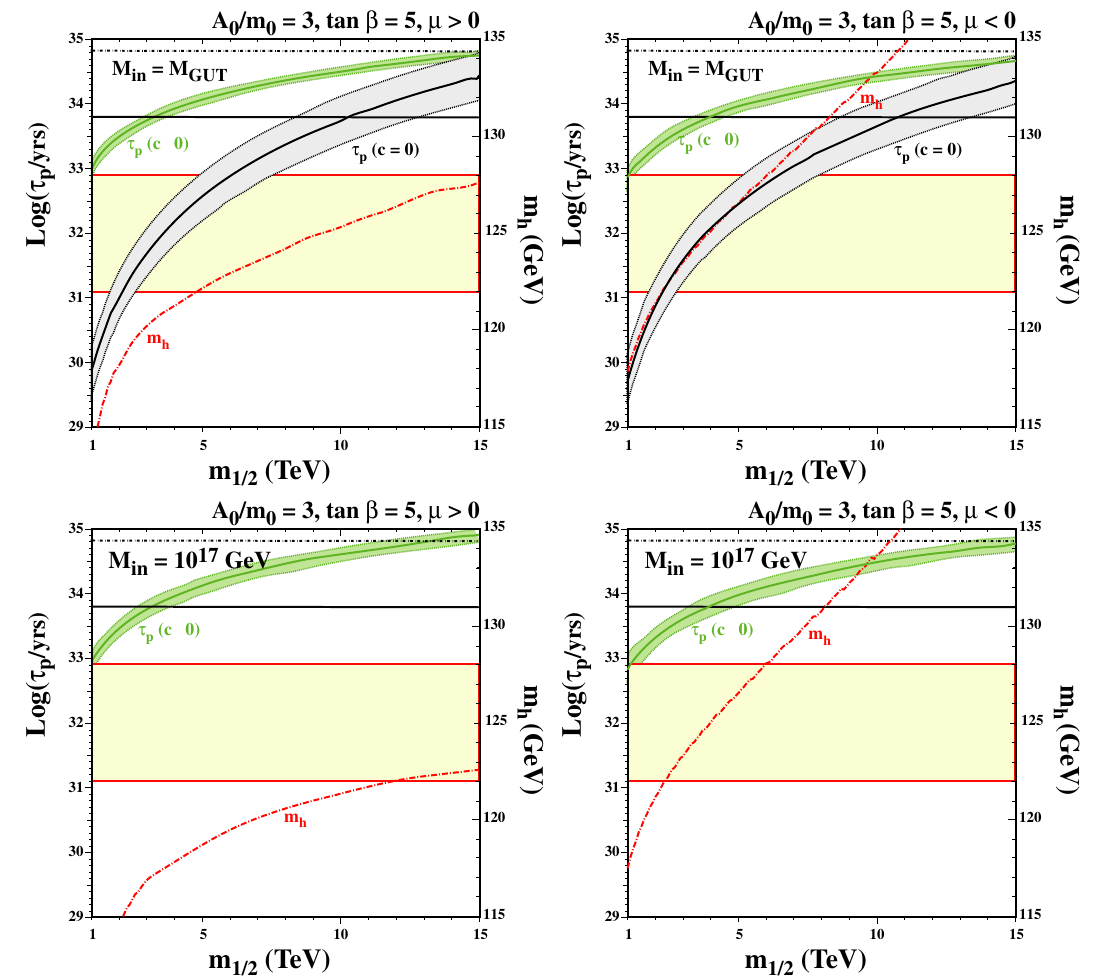
Fig. 11 Some profiles of stop coannihilation strips in the CMSSM (upper panels) and super-GUT models with M in = 10 17 GeV (lower panels), for tan β = 5 , A 0 / m 0 = 3, μ > 0 (left panels) and μ < 0 (right panels). The rising solid black lines are contours of the proton lifetime evaluated with c = 0, the solid green lines are contours of the proton lifetime evaluated with c (cid:15)= 0 (legends on the left axes). The bands surrounding these lines represent ± 1 σ tot uncertainties. The